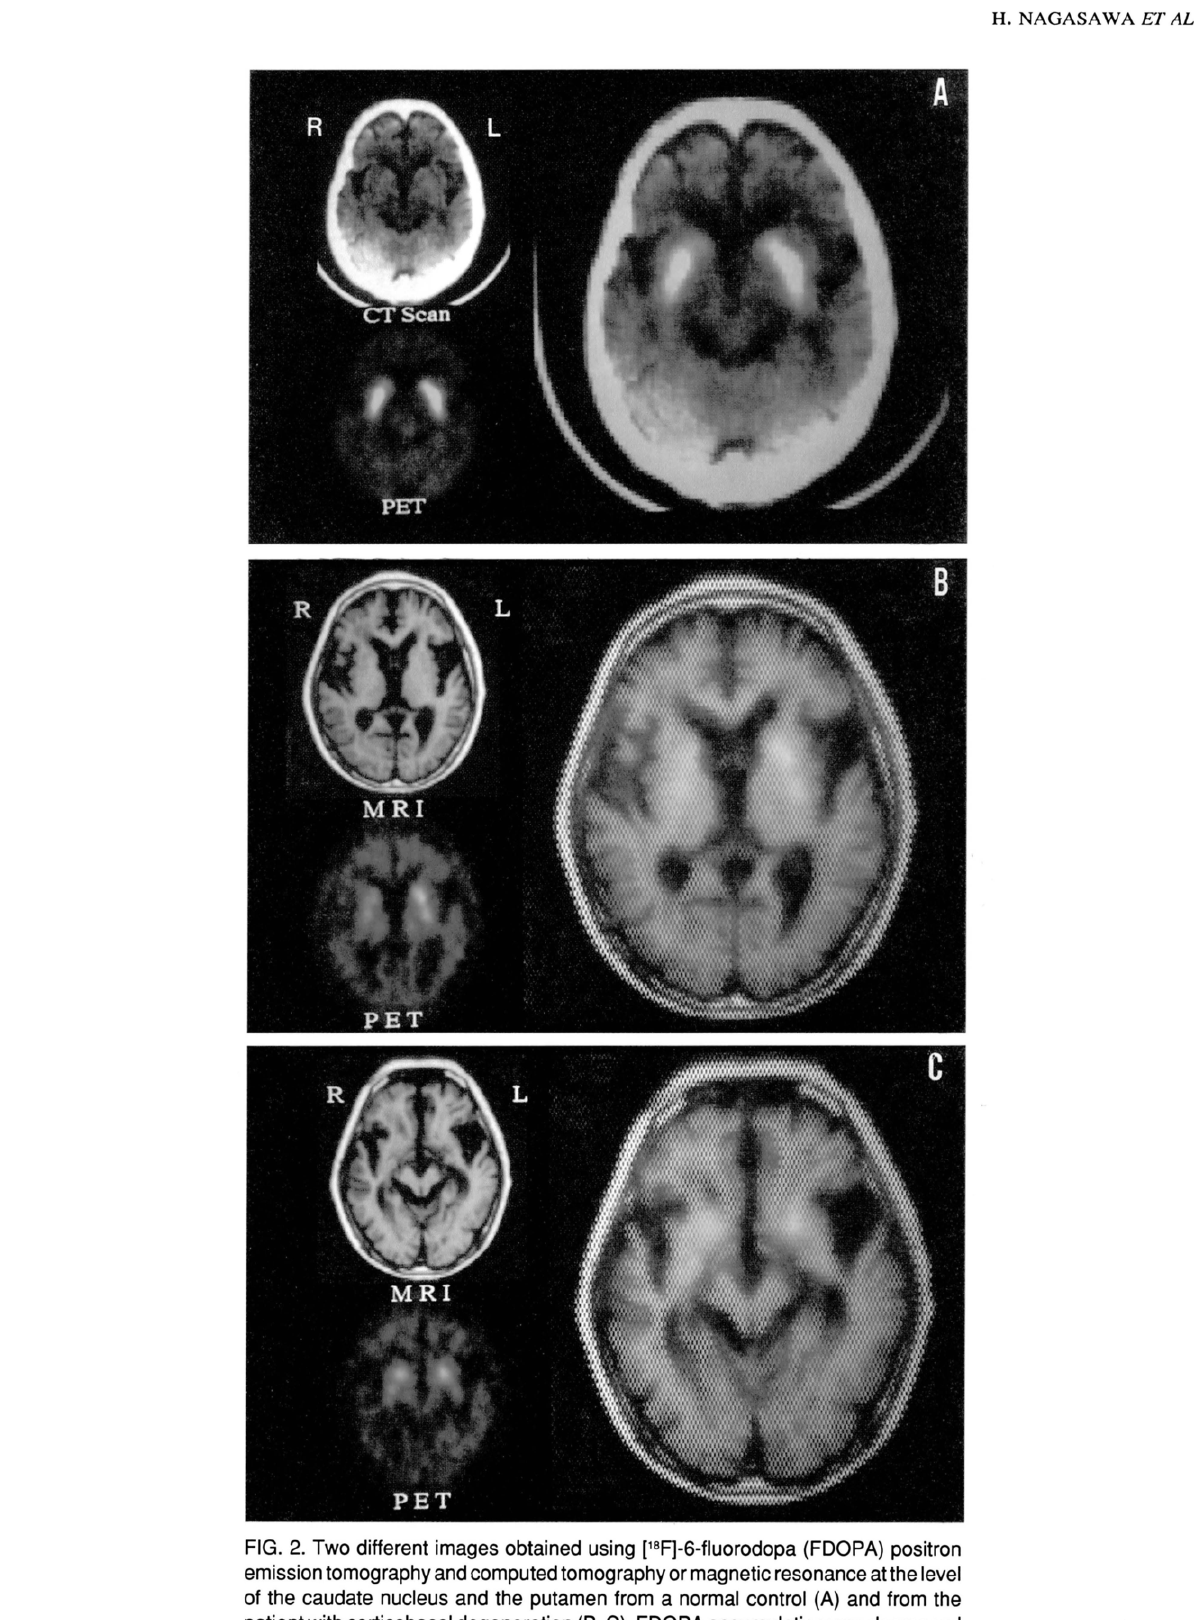
FIG. 2. Two different images obtained using ['BF)-6-fluorodopa (FDOPA) positron emission tomography and computed tomography or magnetic resonance at the level of the caudate nucleus and the putamen from a normal control (A) and from the patient with corticobasal degeneration (8, C). FDOPA accumulation was decreased in the caudate nucleus and the putamen. This decrease was more severe on the right side of the brain than the